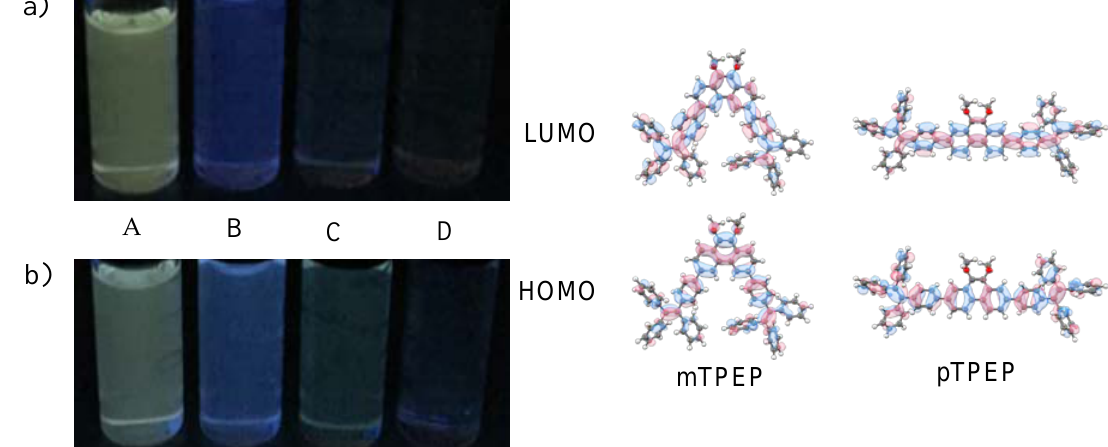
Figure 1. Photographs of ( a ) mTPEP and ( b ) pTPEP under UV illumination in different solvents: A hexane, B dichloromethane, C THF, and D ethanol; and the frontier molecular orbitals.